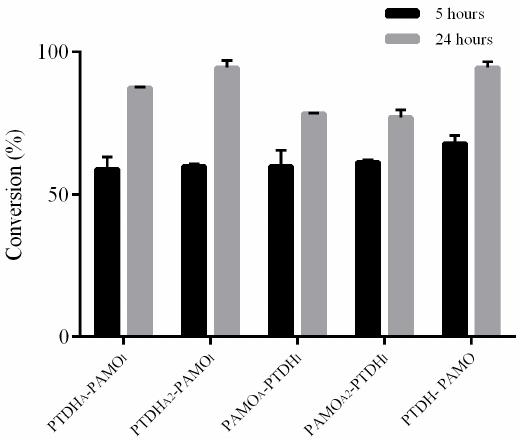
Figure 3. Biotransformation of 5.0 mM bicyclo[3.2.0]hept-2-en-6-one by variants of PAMO, PAMO A , PAMO A2 , and PAMO I . Enzyme assemblies and fusion enzyme were composed of 5.0 µM of the respective PAMO variant and complemented with the respective PTDH concentration based on the used tags.